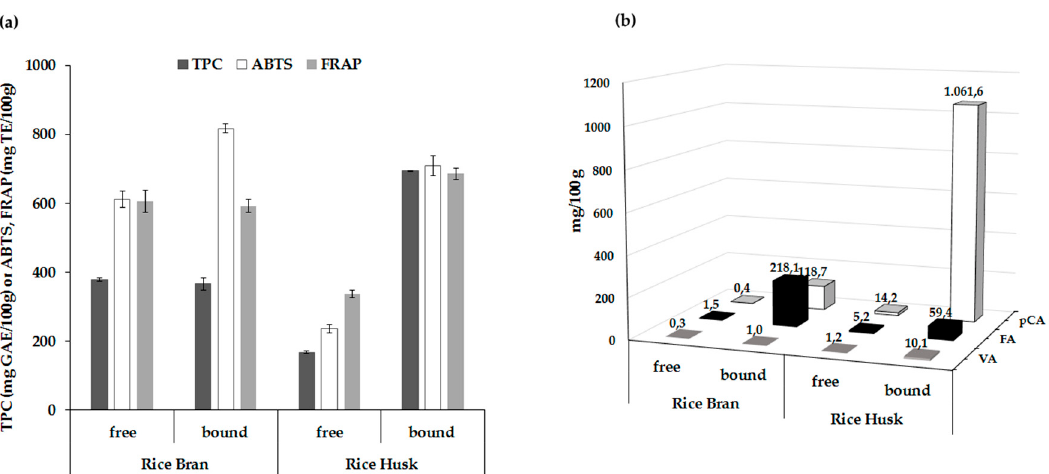
Figure 3. ( a ) Comparison of total phenolic content (TPC), ABTS radical scavenging activity and ferric reducing antioxidant power (FRAP) values of free and bound fractions of rice bran and husks. ( b ) Main phenolic acid composition of free and bound fractions of rice bran and